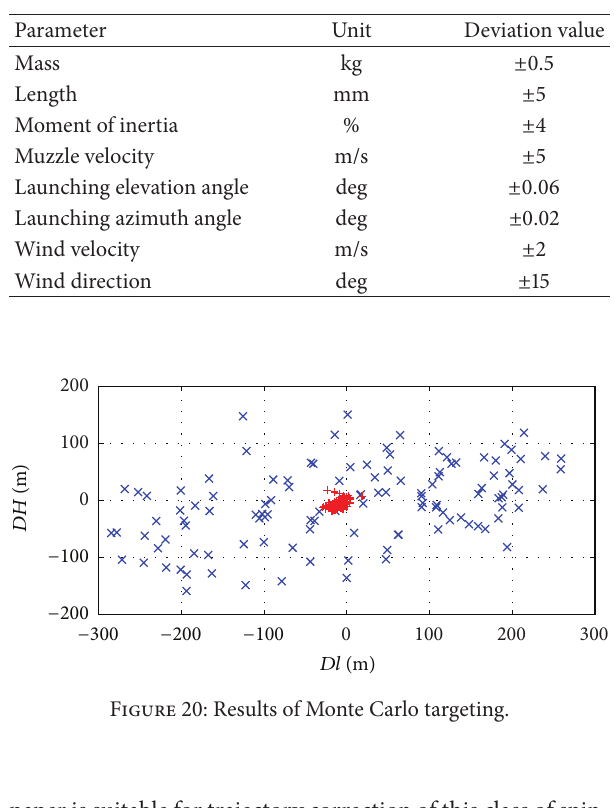
Table 2: Disturbance parameters.